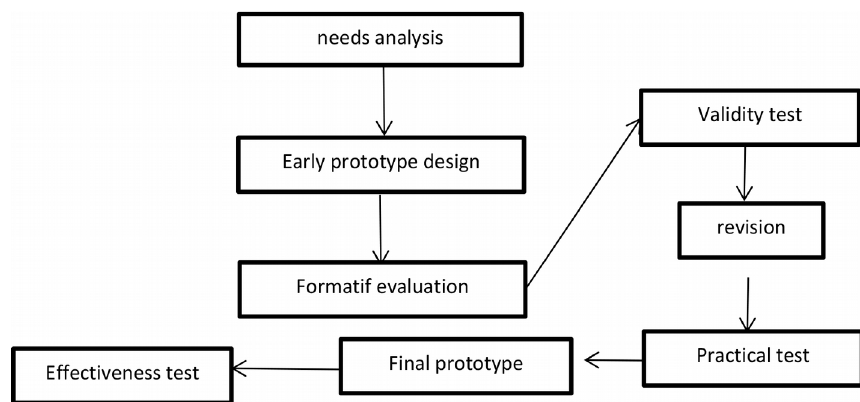
Figure 3. The stages of Research Development (Akker et al., 2006)